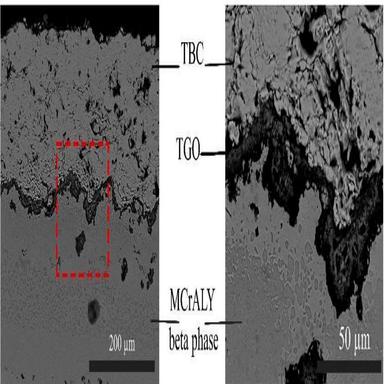
The SEM micrograph of outer coating.